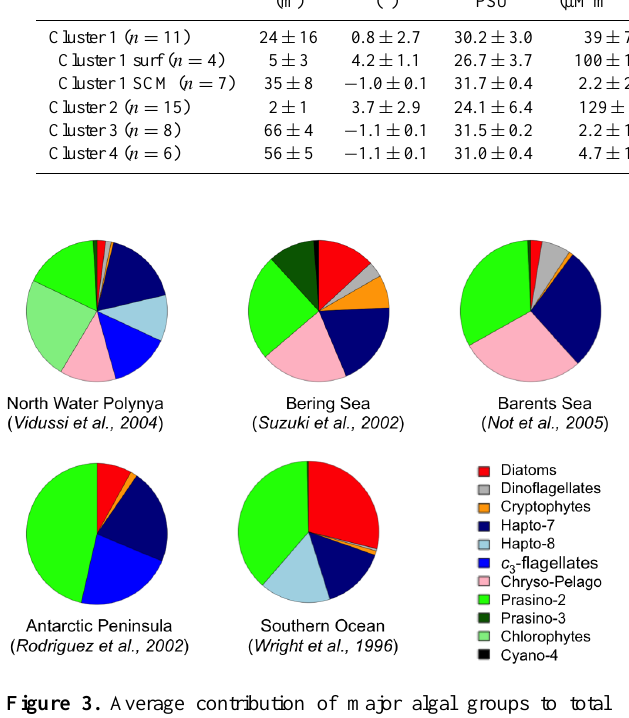
Figure 4. (a) Relative contribution of major algal groups to total chlorophyll a (Chl a ) concentration (calculated by CHEMTAX) for four groups of samples with similar pigment composition (clus- ters) determined with the k -means clustering method (MacQueen, 1967). The geographical position of the four groups of samples (four clusters) is mapped for the (b) surface water and (c) sub- surface chlorophyll maximum (SCM) depth. According to Higgins et al. (2011): Hapto-7: haptophytes type 7; Chryso-Pelago: chryso- phytes and pelagophytes; Prasino-2: prasinophytes type 2; Prasino- 3: prasinophytes type